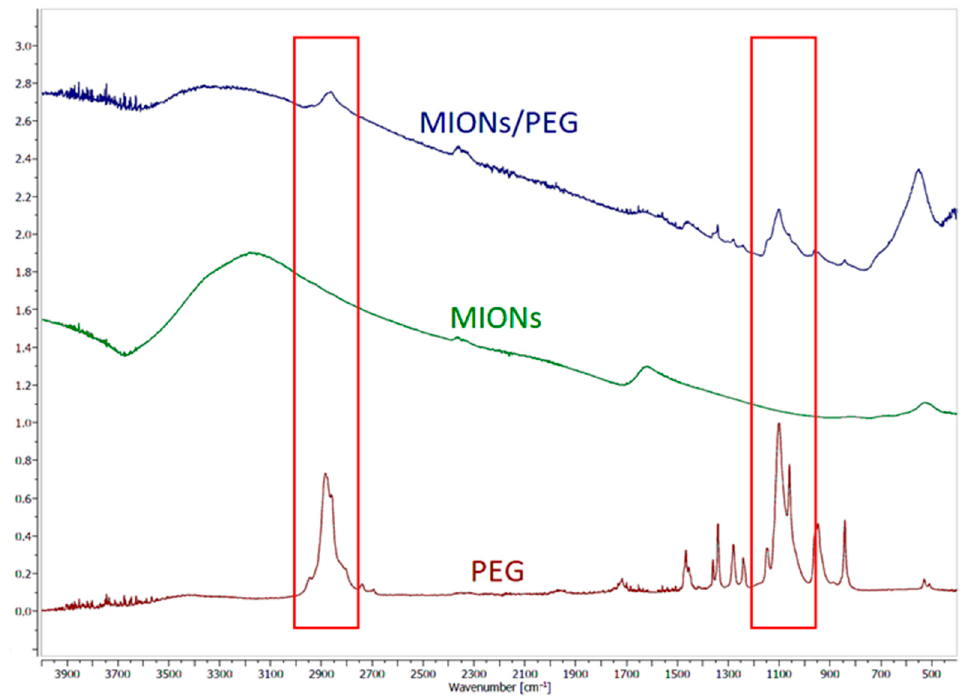
Figure 8. ATR - FTIR spectra of PEG 2000, MIONs and PEG - covered MIONs (sample S8). The red boxes represent the main PEG bands at 2880 cm − 1 and 1100 cm − 1 , also visible on MIONs/PEG spectrum.